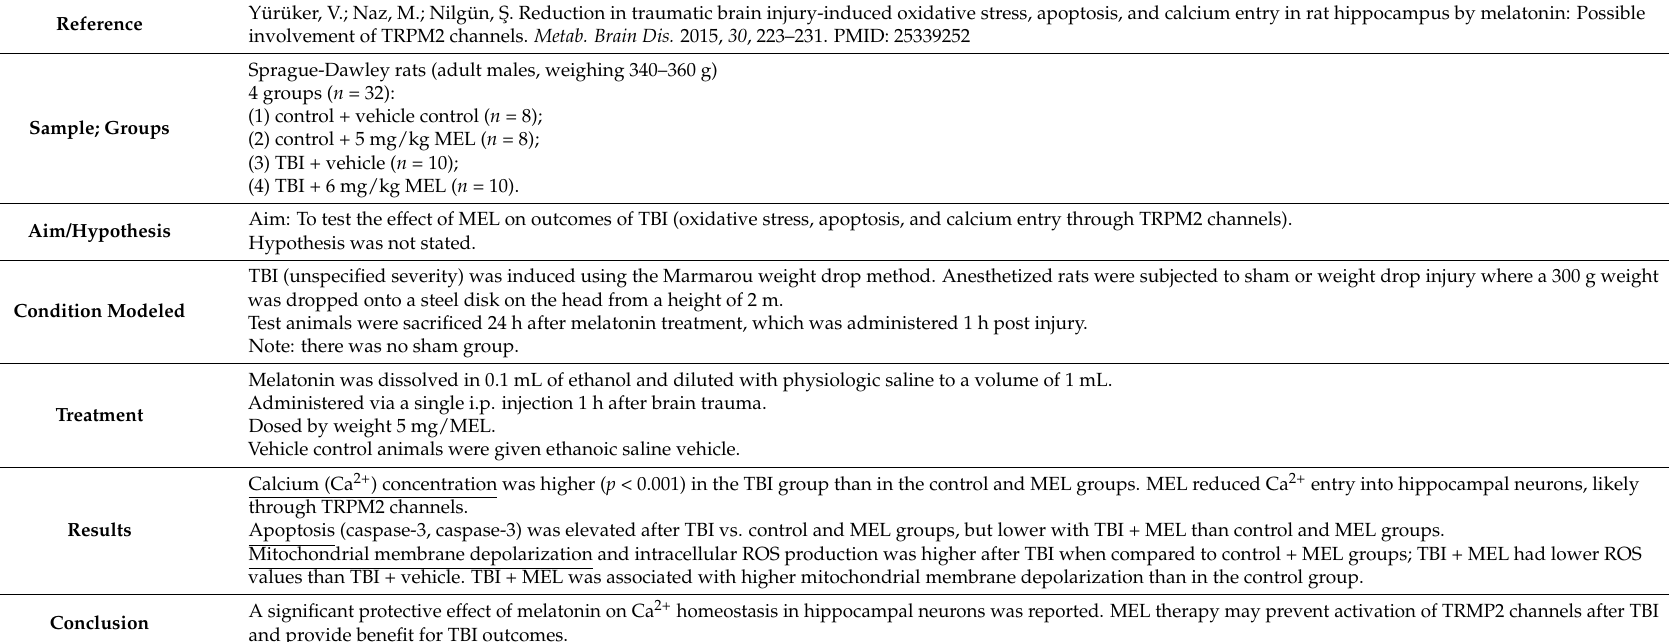
Table A15. Yürüker et al. (2015) Study